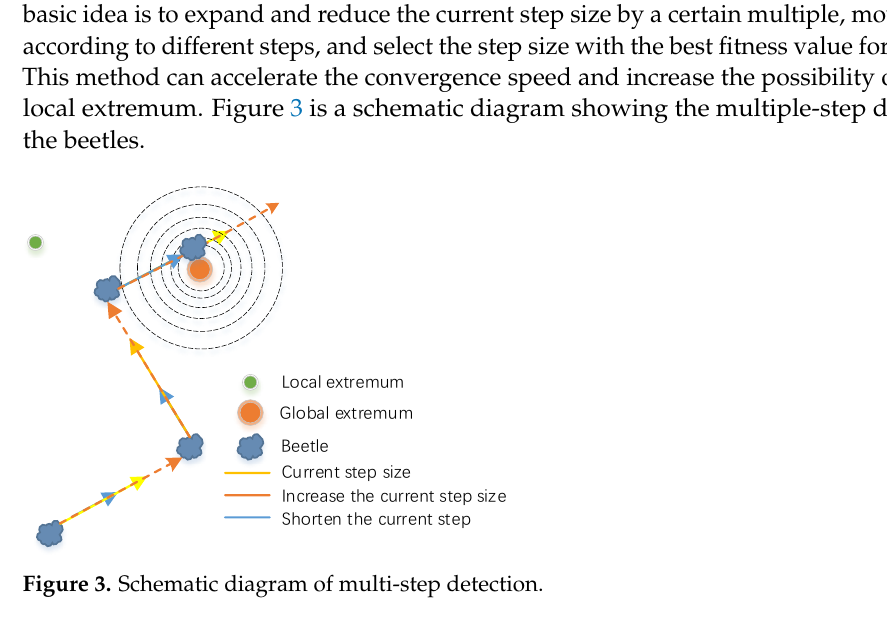
Algorithm 1. Multi-step detection pseudo code